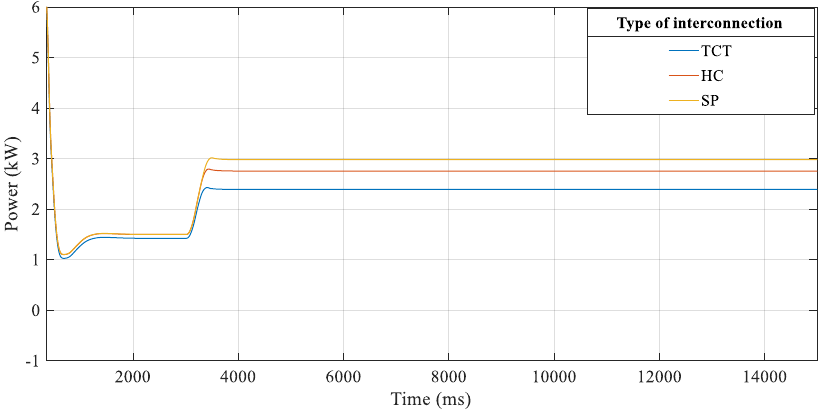
Figure 21. Impact of short- circuit fault ‘F2′ on power grid (monocrystalline PV).